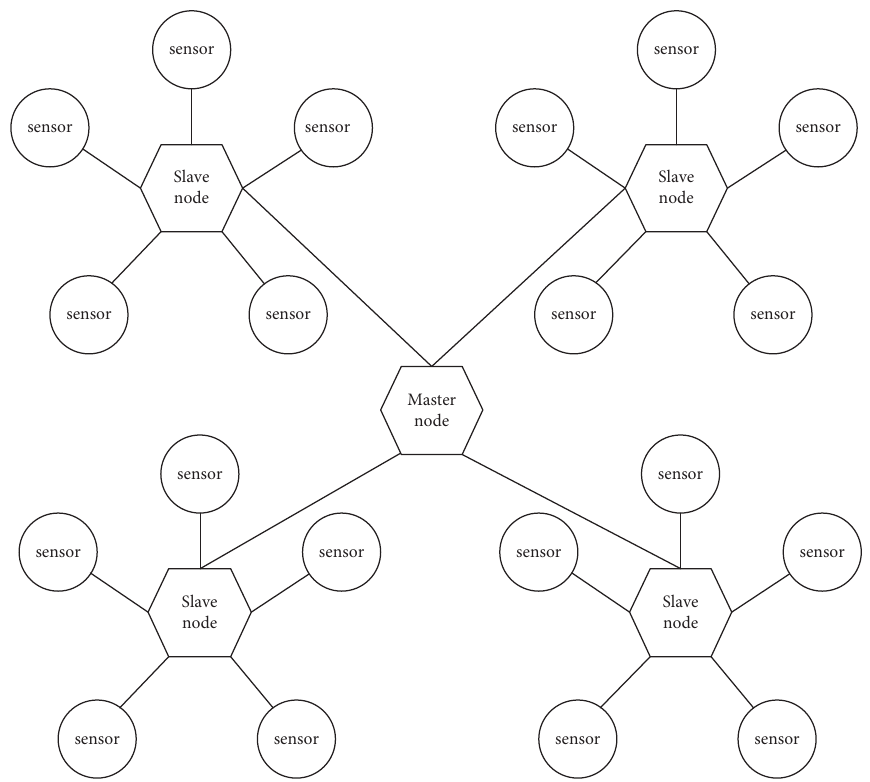
Figure 3: Specific structure of Zigbee wireless sensor